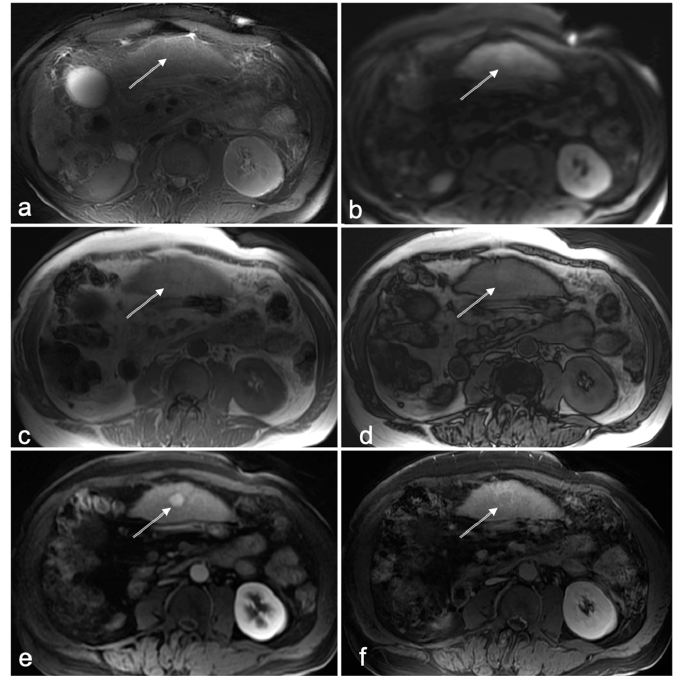
Figure 2. Fifty-two-year-old male patient with liver cirrhosis owing to chronic hepatitis C infection. NC-AMRI ( a – d ) demonstrates a small lesion (arrow ( a – f )) in segment 4 that is hyperintense on axial T2W FS ( a ) and DWI ( b ), and hypointense on T1W in-phase ( c ) and opposed-phase ( d ) imaging, without signs of intracellular fat. CE-MRI ( e , f ) shows hyperenhancement in the arterial phase ( e ) with washout (arrow) in the delayed phase and capsular enhancement ( f ), confirming an HCC lesion (Li-RADS 5 lesion). The lesion was treated with radiofrequency ablation.